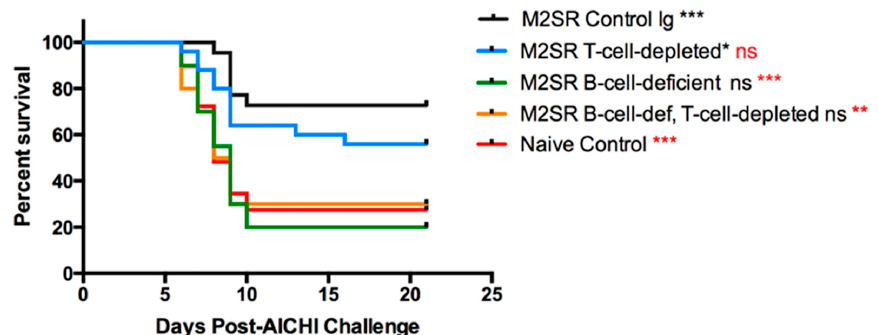
Figure 1. Heterosubtypic immunity to single-replication influenza vaccine, M2SR, is dependent on B cells but not on T cells. Wildtype or B cell-deficient (muMT) mice were vaccinated with M2SR-PR8 and challenged 35 days later with a lethal dose of Aichi as described in the Materials and Methods. Groups of vaccinated mice were depleted of T cells (with 0.5 mg per mouse each of antibodies GK1.5 anti-CD4, 2.43 anti-CD8 and 30H12, anti-Thy1. or 1.5 mg control rat IgG times per week for 2 weeks prior to challenge). The survival was monitored for 21 days after challenge. The survival rate was significantly different from that of the control unvaccinated mice; *** p < 0.001, * p < 0.05 (Mantel–Cox log rank test). The survival rate was significantly different from that of M2SR-vaccinated wildtype mice; *** p < 0.001, ** p < 0.01. The data were pooled from 3 separate experiments with a total of 20–26 mice per group.